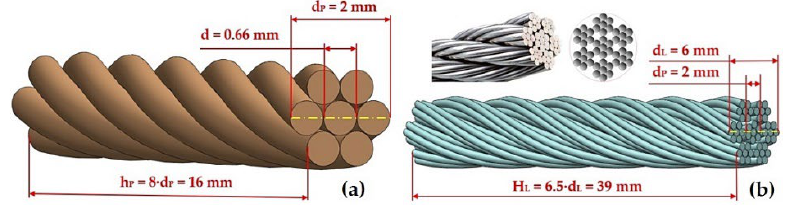
Figure 15. Steel rope ( a ) strand with diameter d p [m], wire with diameter d [m], ( b ) type 6 6 × 7+WSC 1960 B sZ.